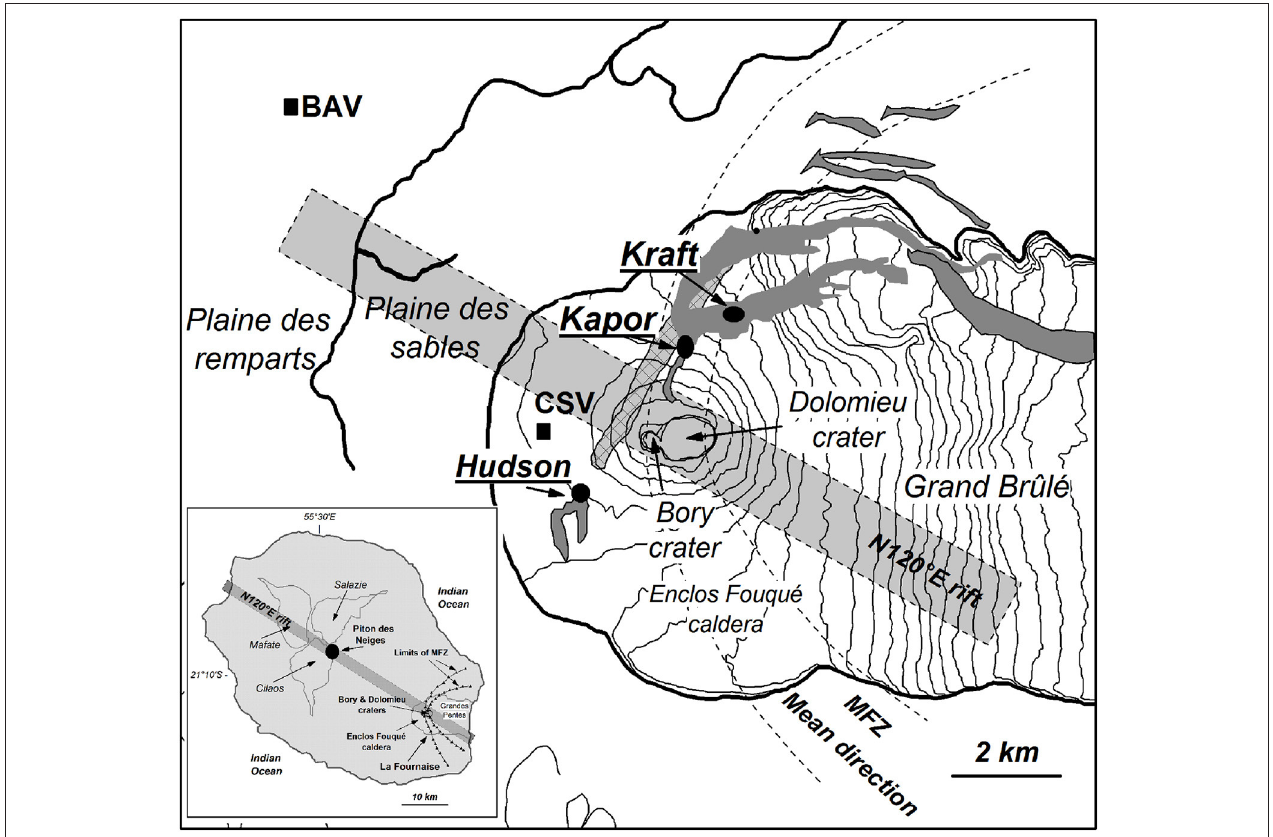
FIGURE 1 | Sketch of La Fournaise volcano, from Wawrzyniak et al. (2017). BAV and CSV are the electromagnetic stations. Lava flows emitted by Krafft, Kapor, and Hudson cones are in dark gray color. Dashed lines represent the main fracture zone along which most fissure eruptions occur. The gray rectangle illustrates the regional N120 ◦ E volcanic and fissural axis. Gray cross pattern corresponds to the trace of main earthquakes associated with the March 9, 1998,